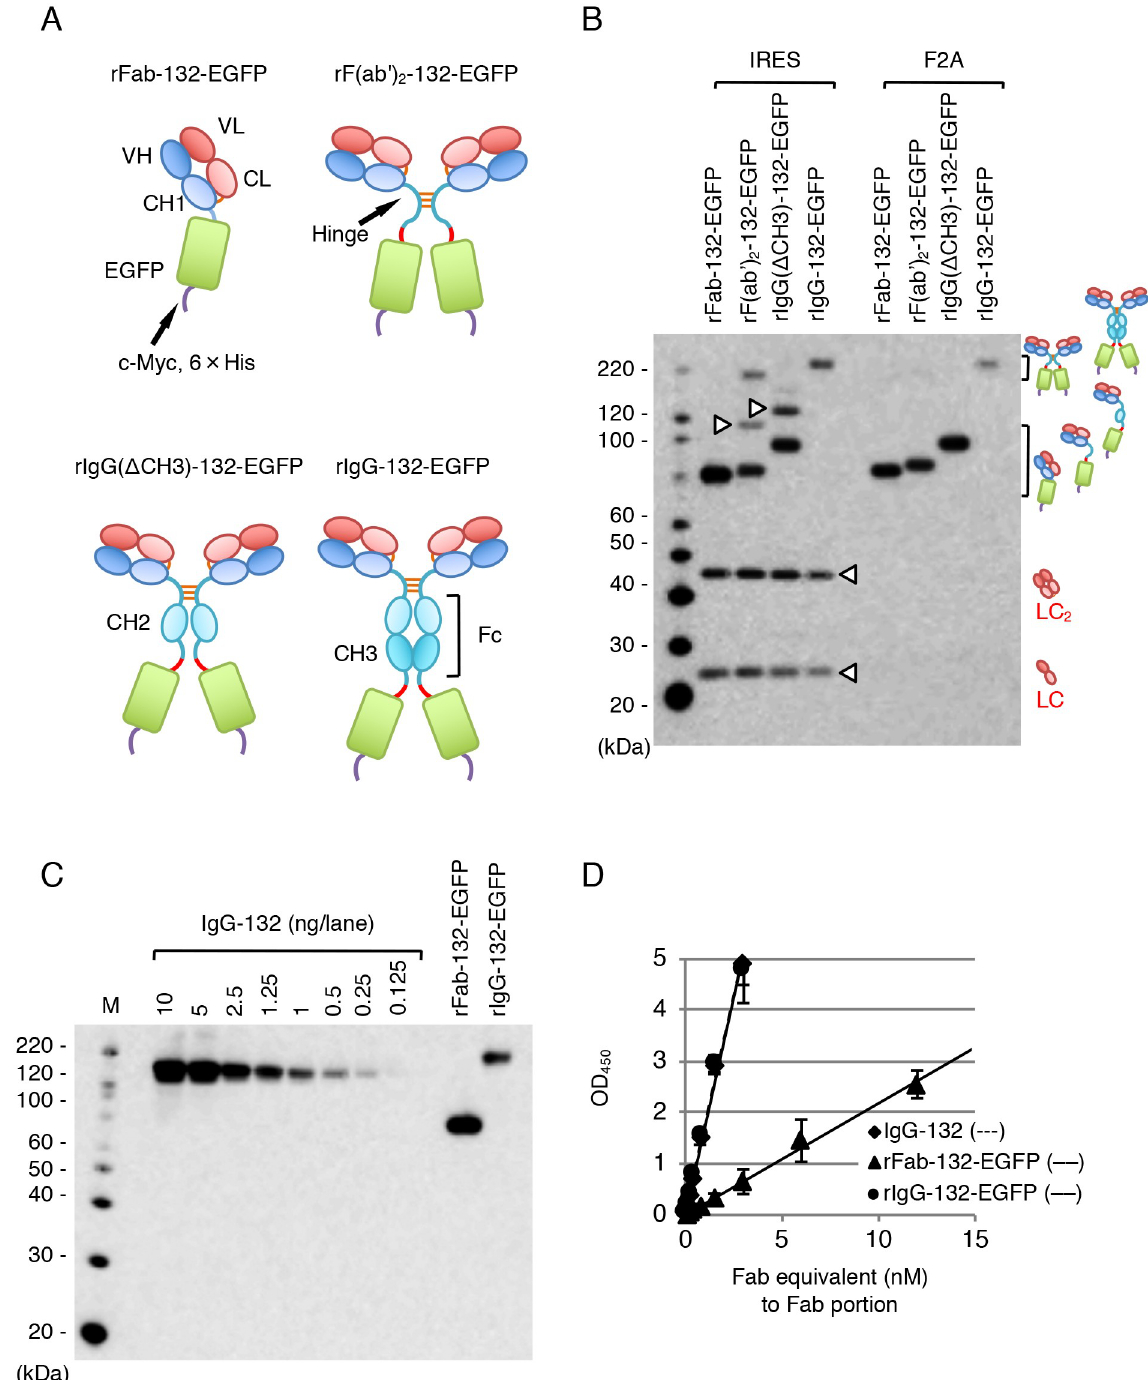
Fig 3. Reactivity of mAb 132-EGFP fusion proteins. (A) Molecular design of mAb 132-EGFP fusion proteins. The light and heavy chains are depicted as in Fig 1A, and the spacer between heavy chains and EGFP is indicated with red lines. The epitope tag consisting of c-Myc epitope and a 6 × His (purple lines) was added at the C-terminus of EGFP. (B) Analysis of the molecular assembly of mAb 132-EGFP fusion proteins. Expression plasmids were introduced into HEK293T cells and mAb 132-EGFP fusion proteins were detected with a HRP-conjugated anti- mouse IgG (Fab specific) (Sigma). Corresponding illustrations on the right indicate the products of rFab-EGFP, rF(ab’) 2 -132-EGFP, rIgG ( Δ CH3)-132-EGFP and rIgG-132-EGFP, whereas arrowheads indicate possible assembly intermediates, free light chain and free light chain dimer (LC 2 ). The square brackets indicate the molecular weight range of mono- and bivalent fusion proteins. (C) Quantification of purified rFab-132-EGPG and rIgG-132-EGFP. Concentrations of fusion proteins were estimated by comparing 2-fold serially diluted authentic IgG-132